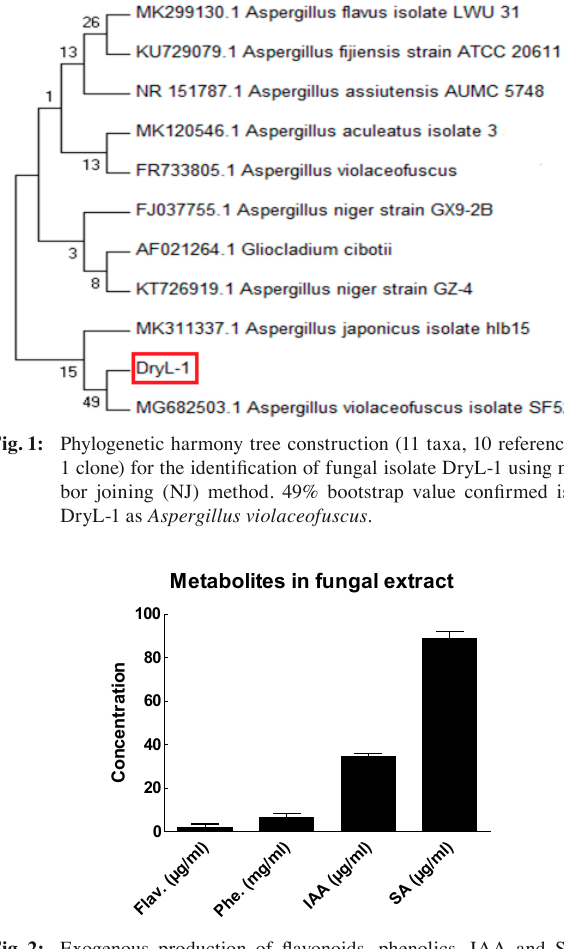
Fig. 2: Exogenous production of flavonoids, phenolics, IAA and SA by A. violaceofuscus in their CF cultured in Czapek broth for one week using shaking incubator (120 rpm at 28 °C). Data are means of tri- plicates with standard error bars.